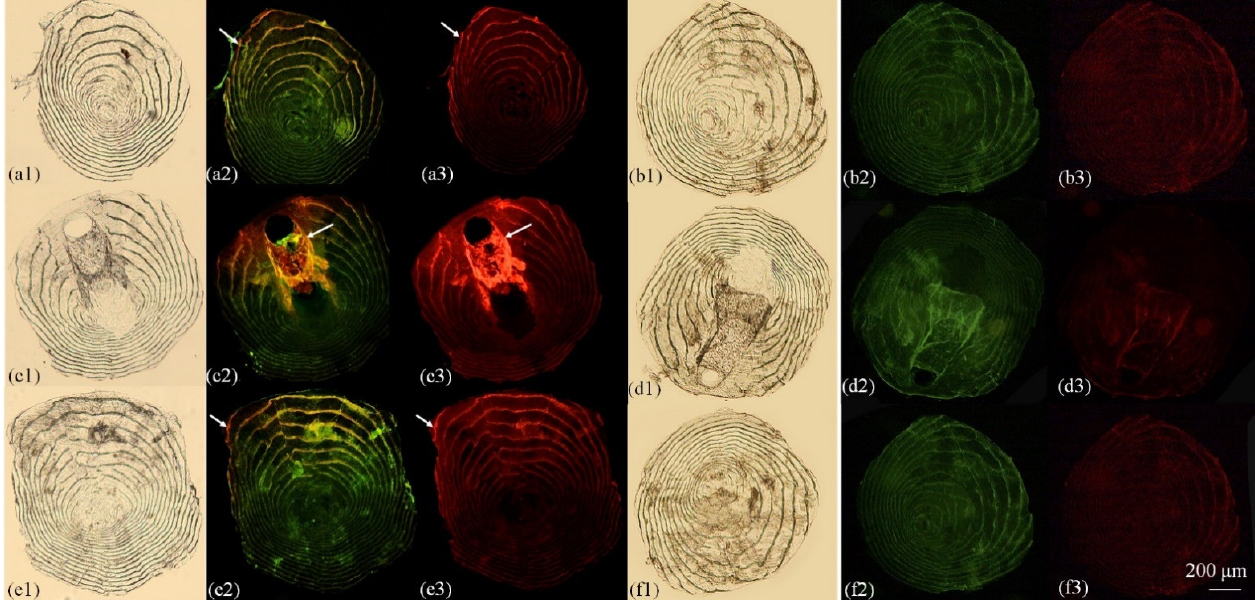
Figure 4. The typical patterns of marking when alizarin complexone (ALC) is used for marking scales in juvenile silver carp Hypophthalmichthys molitrix . Note: ( a1 ), ALC-marked scales above the lateral line under transmitted light; ( a2 ), ALC-marked scales above the lateral line under blue excitation light; ( a3 ), ALC-marked scales above the lateral line under green excitation light; ( b1 ), control scales above the lateral line under transmitted light; ( b2 ), control scales above the lateral line under blue excitation light; ( b3 ), control scales above the lateral line under green excitation light; ( c1 ), ALC-marked scales on the lateral line under transmitted light; ( c2 ), ALC-marked scales on the lateral line under blue excitation light; ( c3 ), ALC-marked scales on the lateral line under green excitation light; ( d1 ), control scales on the lateral line under transmitted light; ( d2 ), control scales on the lateral line under blue excitation light; ( d3 ), control scales on the lateral line under green excitation light; ( e1 ), ALC-marked scales below the lateral line under transmitted light; ( e2 ), ALC-marked scales below the lateral line under blue excitation light; ( e3 ), ALC-marked scales below the lateral line under green excitation light; ( f1 ), control scales below the lateral line under transmitted light; ( f2 ), control scales below the lateral line under blue excitation light; ( f3 ), control scales below the lateral line under green excitation light. The white arrows point to the fluorescent marks.